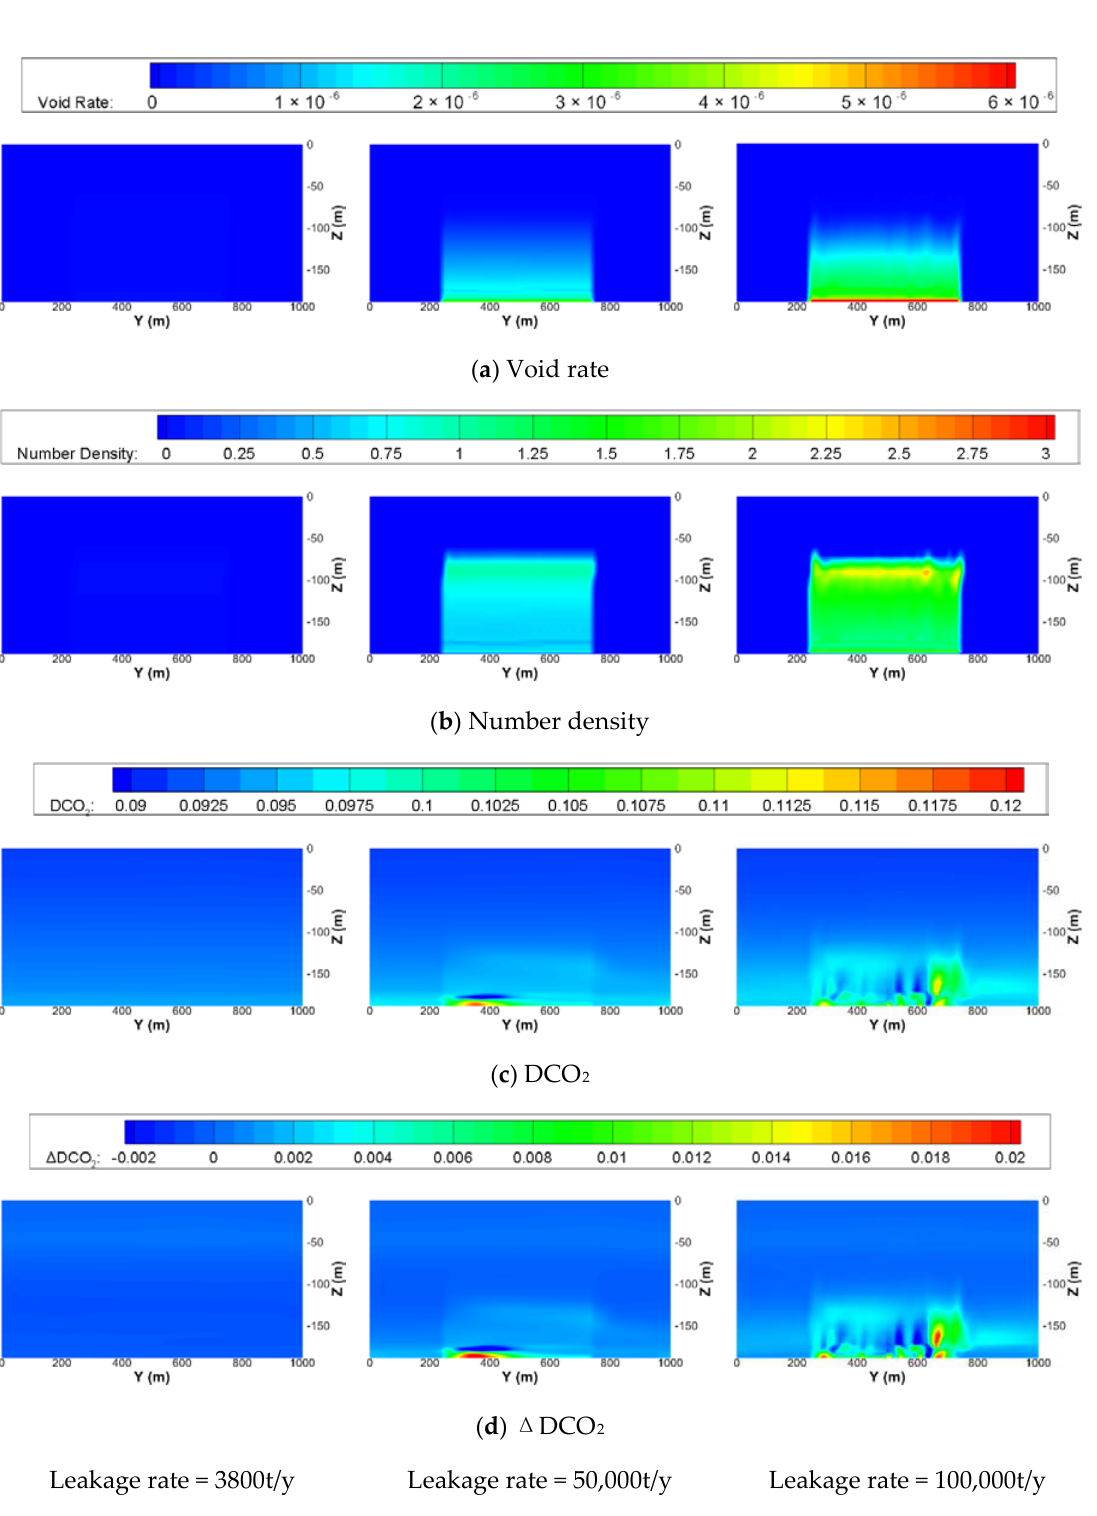
Figure 7. Contour maps of ( a ) void rate, ( b ) number density of undissolved CO 2 bubbles, ( c ) DCO 2 , and ( d ) Δ DCO 2 on the center plane in the x direction (x = 1000 m) of the small-scale domain at 30 days after the start of leakage with the same initial diameter of bubble of 20 mm and leakage area of 20,000 m 2 but different leakage rates.